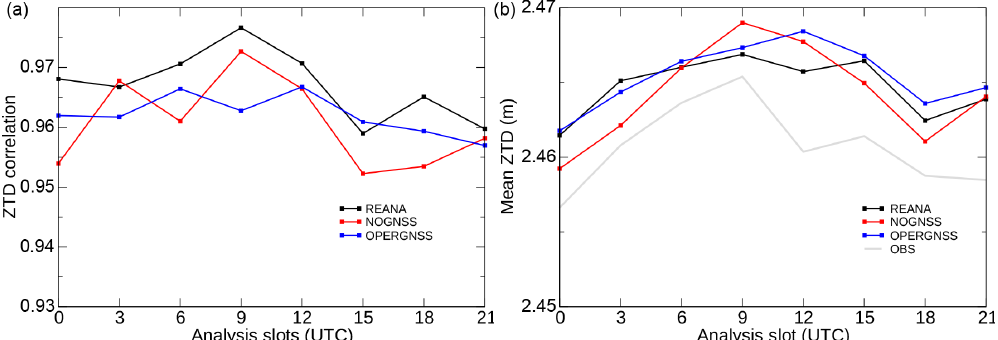
Figure 4. Correlation of the differences between zenithal total delays (ZTD) between REANA (black), NOGNSS (red) and OPERGNSS (blue) analyses and corresponding Marfret Niolon independent observations as a function of analysis time in (a) ; mean value of ZTD (m) in (b) , the grey line corresponding to observations.